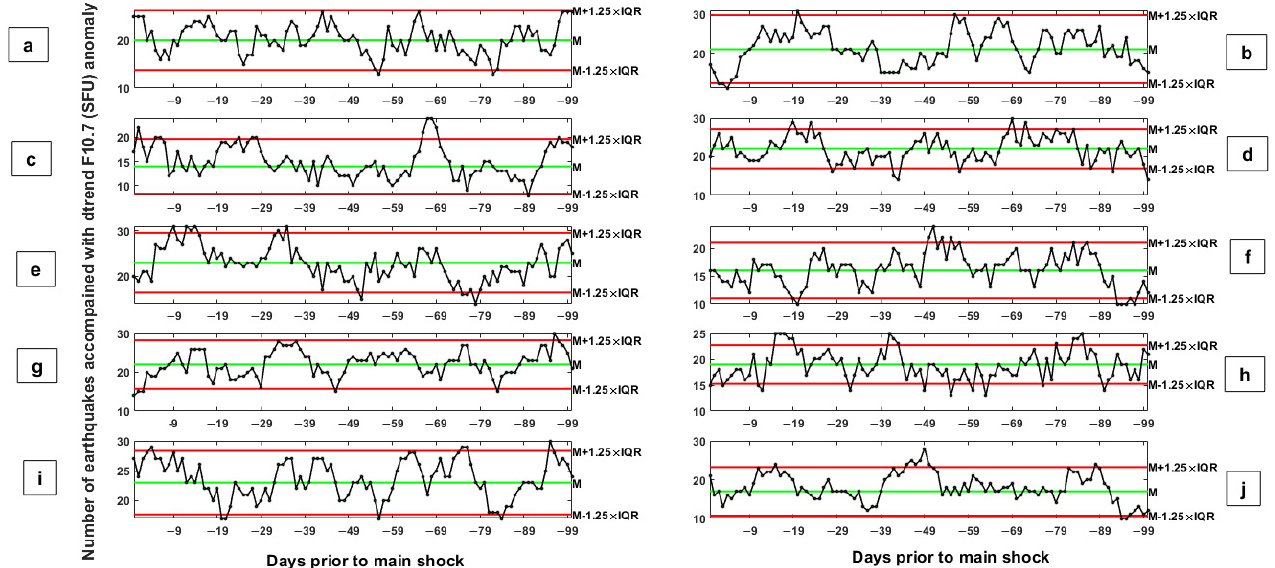
Figure 10. Panels ( a – j ) show results of 10 simulated earthquakes dataset. The y -axis in each panel indicates the number of simulated earthquakes accompanied by anomalous changes in the dtrend F10.7 index during the days prior to the simulated earthquakes. Median and higher and lower bounds are drawn as green and red horizontal lines, respectively. The allowed ranges are defined as M ± 1.25 × IQR , in which M and IQR are the median and the inter-quartile range parameters, respectively.